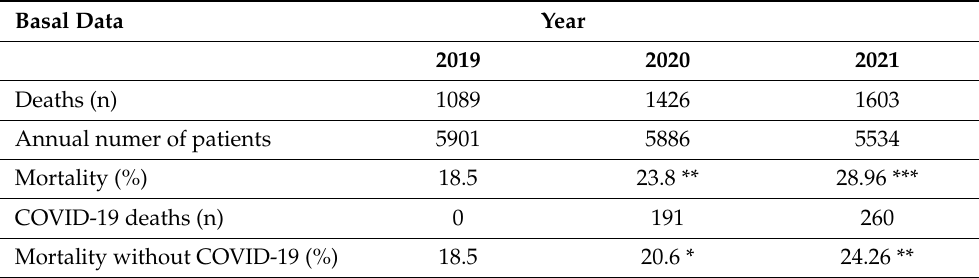
Table 3. Basal data in mortality in 2019, 2020, and 2021 in relation to COVID-19. Basal Data